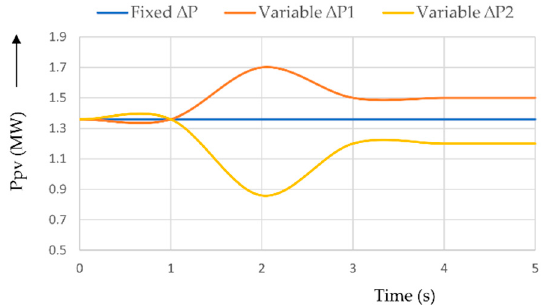
Figure 14. PV output voltage waveform for fixed and variable power reserve control. Table 1. Parameters of PV array.